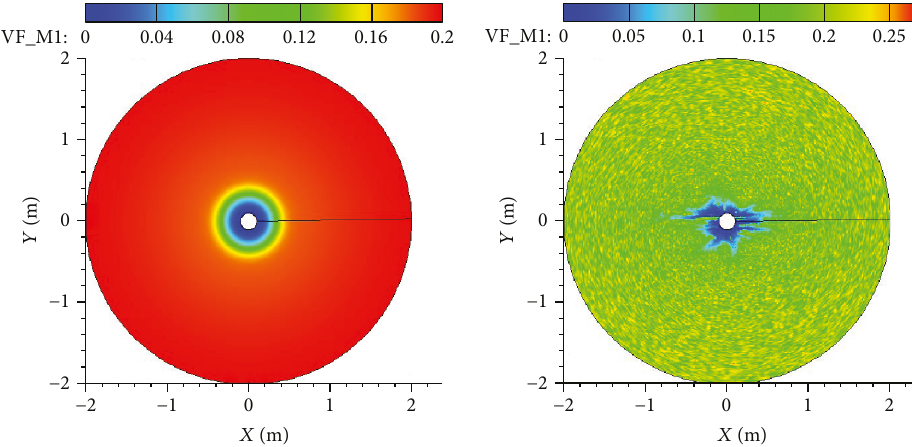
Figure 9: Fast-reacting mineral distribution after acidizing for homogeneous and heterogeneous initial distributions.